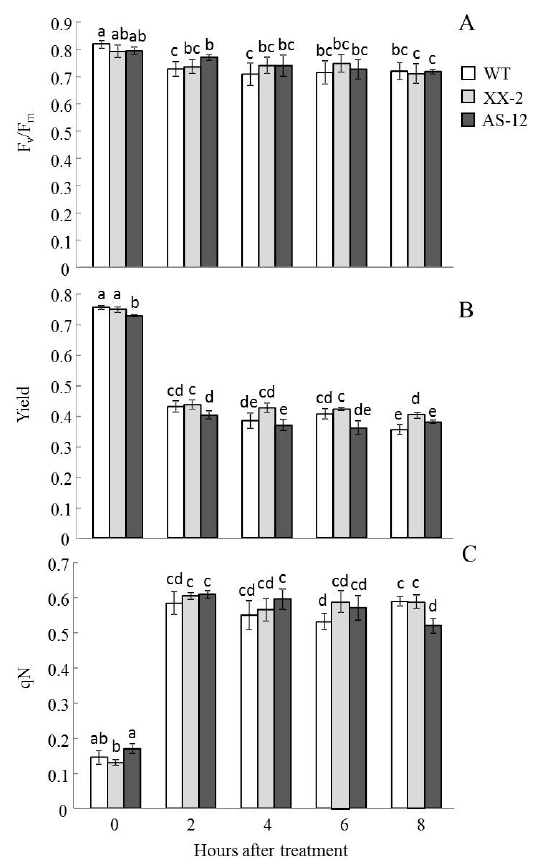
Figure 2. Parameters of Chl fluorescence. Maximum and actual photochemical efficiency of PSII expressed as F v /F m ( A ) and Yield ( B ) respectively, and the coefficient of non-photochemical quenching or qN ( C ) in leaves of WT, XX-2, and AS-12 Arabidopsis thaliana plants grown at 90 μ mol m − 2 s − 1 (0 h) and after 2–8 h of moderately high light (400 μ mol m − 2 s − 1 ). Data are presented as mean ± SE of values from three independent experiments (n = 6–10 for each experiment). Significant differences between mean values (ANOVA, Duncan’s test, p < 0.05) are indicated by different letters (a, b, c, d, e). The same or double letters (ab, cb, cd, de) indicate no significant differences between the means.